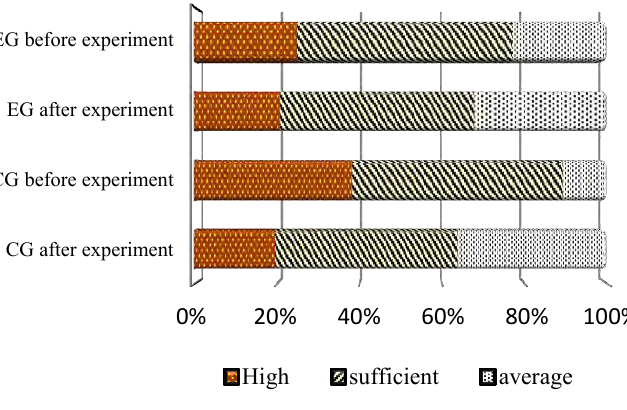
Fig.2. Distribution of experimental and control groups’ teachers by levels at the beginning and at the end of